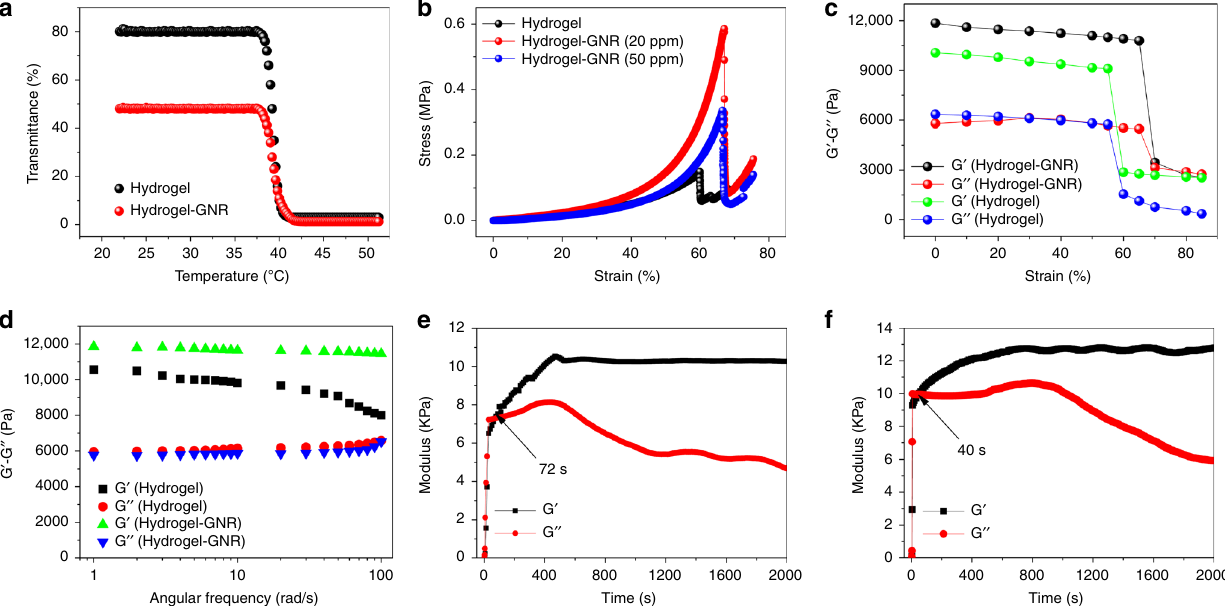
Fig. 2 Rheological measurements of composite hydrogel and hydrogel – GNR. a Temperature-dependent transmittance of hydrogel and hydrogel – GNR, and the temperature corresponding to the abrupt drop point is designated as the LCST. b Compressive stress – strain curves of hydrogel, hydrogel – GNR (20 ppm), and hydrogel – GNR (50 ppm), respectively. c Strain amplitude sweeps of hydrogel and hydrogel – GNR performed at 39 °C at a constant frequency of 1 rad s − 1 , d Dynamic oscillatory frequency sweeps of hydrogel and hydrogel – GNR at a fi xed strain of 1%. e , f Time-dependent sweep tests of hydrogel ( e ) and hydrogel – GNR ( f ). Notes: hydrogel represents CS/mPEG-Mal/pNIPAAm- co -AAc with 20% AAc in pNIPAAm- co